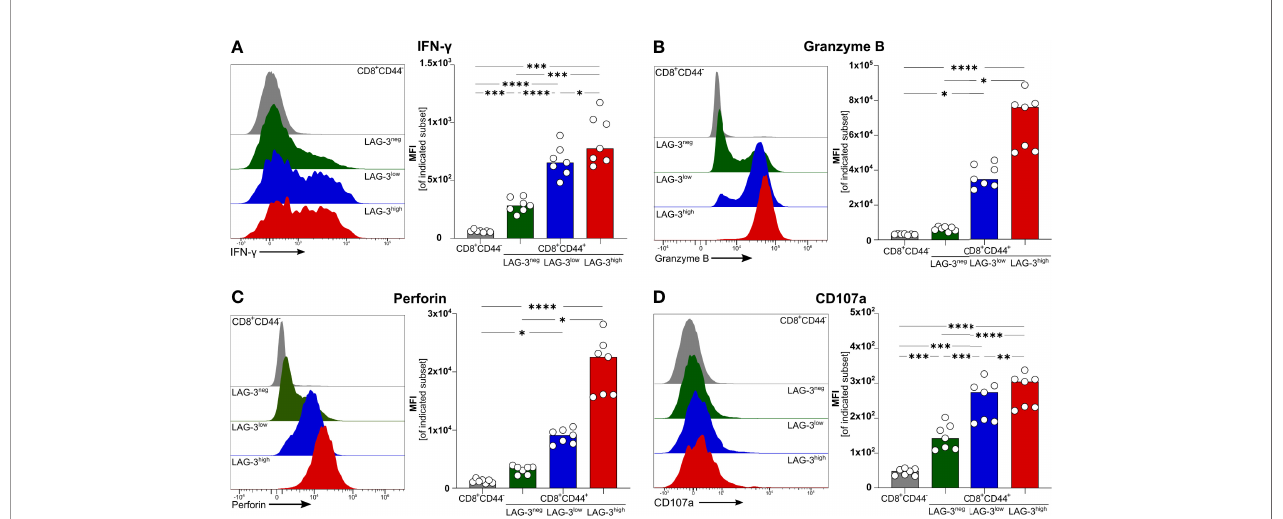
FIGURE 2 | Expression of effector molecules correlates with LAG-3 expression. Exemplary histograms and MFI of (A) IFN- g , (B) Granzyme B, (C) Perforin and (D) CD107a expressed by CD8 + CD44 + cells expressing different levels of LAG-3 (CD8 + CD44 + LAG-3 neg , CD8 + CD44 + LAG-3 low , CD8 + CD44 + LAG-3 high ) and by CD8 + CD44 - T cells. Cells were isolated from the spleens of C57BL/6J infected with PbA 6 days post-infection. For B&C, cells were stained directly ex vivo. For A&D, cells were stained after 5 h restimulation with PMA/Iono in the presence of Brefeldin A and Monensin. Data were analyzed with Tukey test for multiple comparisons (A&D) or Friedmann ’ s test (B&C). Each dot represents an individual mouse, n=7. P values ≤ 0.05 (*), ≤ 0.01 (**), ≤ 0.001 (***) or ≤ 0.0001 (****) were considered statistically signi fi